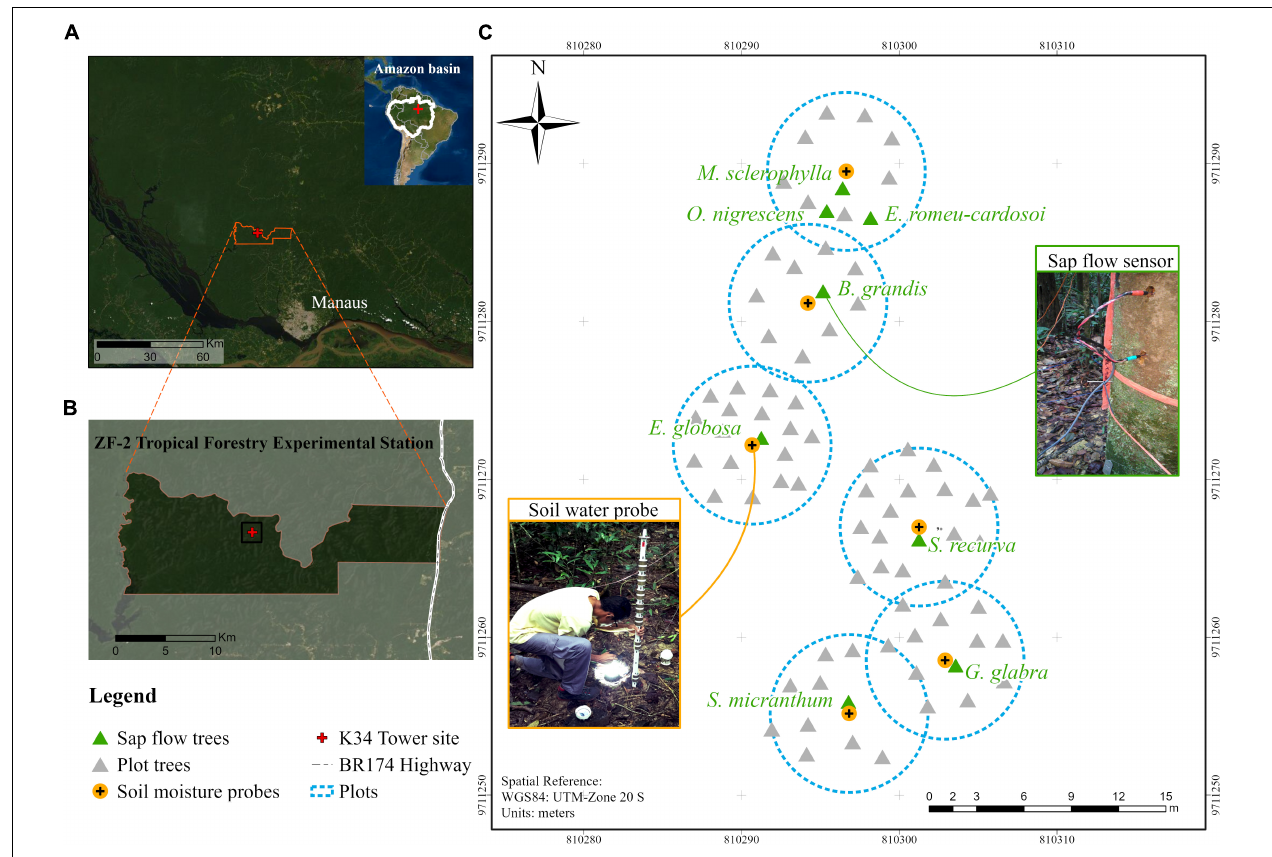
FIGURE 2 | (A) Location of the study in the central Amazon at the (B) ZF2 forest research area north of Manaus, Brazil. (C) Spatial location of the sap flow and soil moisture instrumentation—dominant trees with installed sap flow sensors are labeled in green and associated soil water profile sensors are numbered in orange. The circular plot was delineated as a 5-m radius from the soil water sensor, and the diameter at breast height of all trees > 5 cm diameter within this plot were measured for scaling water use. The Large-Scale Biosphere-Atmosphere Experiment in Amazonia (LBA) K34 eddy covariance tower is labeled in red.